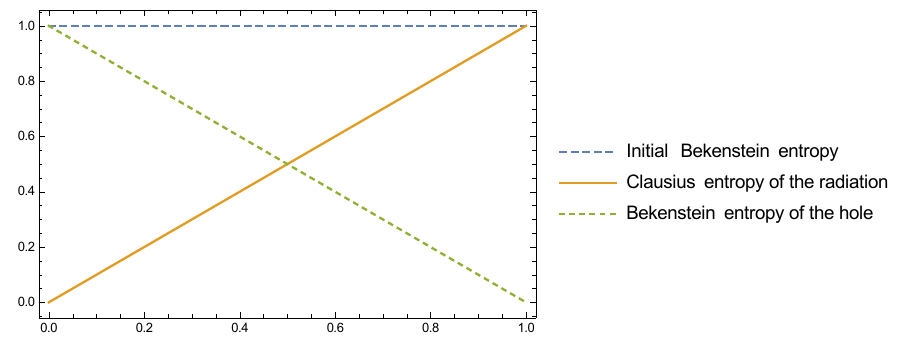
Figure 1. Clausius (thermodynamic) entropy balance: As the black hole Bekenstein entropy (defined in terms of the area of the horizon) decreases, the Clausius entropy of the radiation increases, to keep total entropy constant and equal to the initial Bekenstein